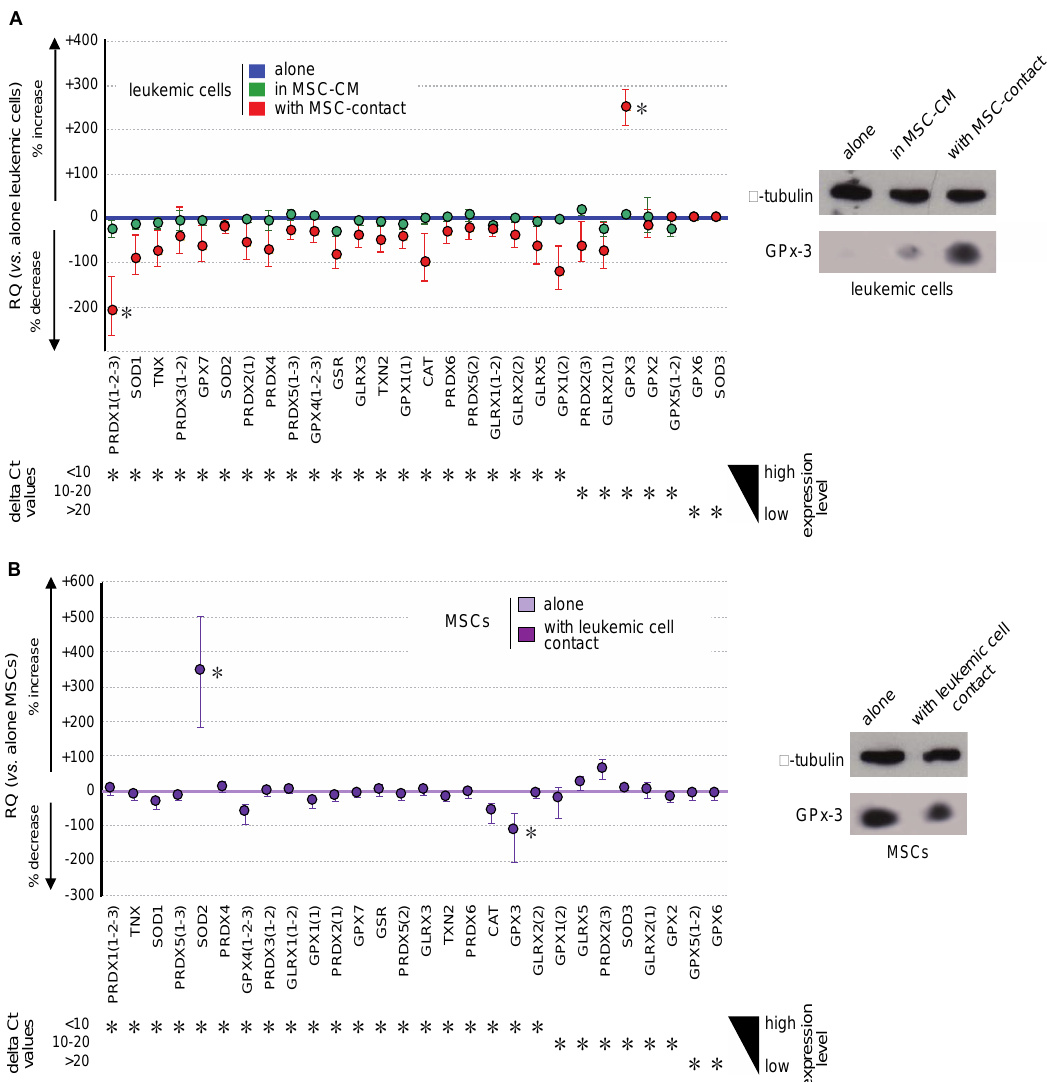
Figure 5. Leukemic cells and MSCs reciprocally modify their gene expression profile of antioxidant enzymes. ( A ) Gene expression of the major antioxidant enzymes was analyzed by real-time PCR in KG1a cells and is presented, from the highest to the lowest expressed genes in KG1a cells, as the percentage of increased or decreased relative expression (RQ = 2 − ∆∆ C t ) in KG1a cells cultured in MSC-CM (green dots) or cocultured with MSCs (red dots) vs. KG1a cells alone (blue line) (left). Increased GPX3 expression was studied at the protein level by Western blot analysis (right), alpha-tubulin being used as loading control. ( B ) Gene expression of major antioxidant enzymes was analyzed by real-time PCR in MSCs and is presented, from the highest to the lowest expressed gene in MSCs alone, as the percentage of increased or decreased relative expression (RQ = 2 − ∆∆ C t ) in cocultured MSCs (violet dots) vs. MSCs alone (violet line) (left). Decreased GPX3 expression was confirmed at the protein level by Western blot analysis (right), alpha-tubulin being used as loading control. * p < 0.05. GPX3 is known as a determinant of leukemic hematopoiesis [23] and its niche-induced overex- pression in leukemic cells fits well with modifications in redox metabolism. Interestingly, among the nine stromal cell-lines studied, the highest level of GPX3 was found in MS-5 (Figure S1), the mesen- chymal cell-line able to efficiently support hematopoiesis, pointing out GPx3 as an important regula- tor of oxidative metabolism in MSCs.